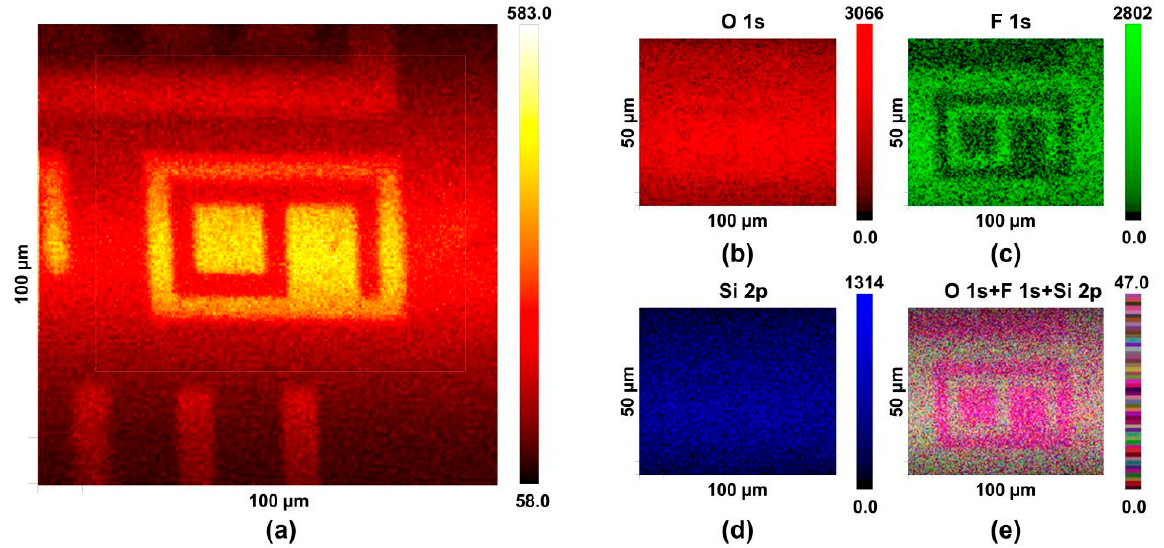
Figure 8. ( a ) Induced secondary electron image (SXI) of an area of 50 µm by 50 µm. Reconstructed mapping image of chemical states within the same area shown in ( a ). ( b ) O 1s, ( c ) F 1s, ( d ) Si 2p, and ( e ) O 1s+F 1s+Si 2p.